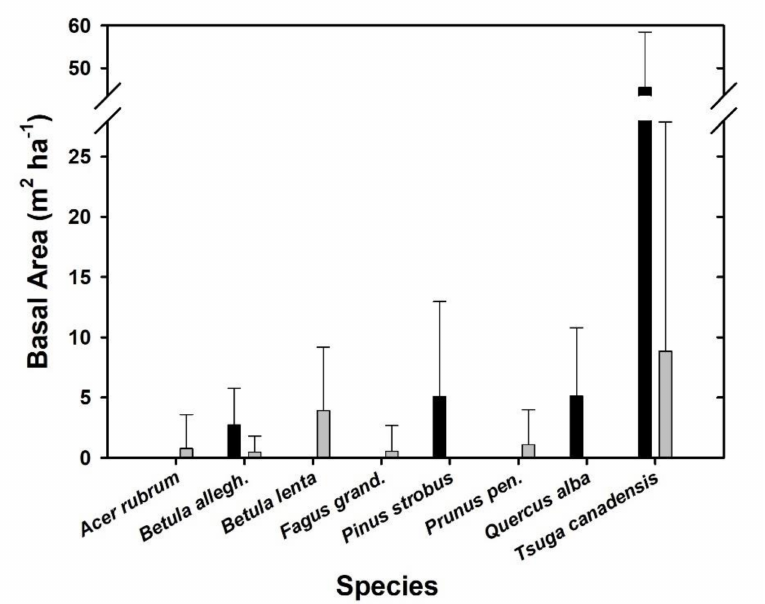
Figure 1. Pre-disturbance (black bars) and ten years post-disturbance (grey bars) basal area of standing live trees > 10 cm dbh, for the dominant